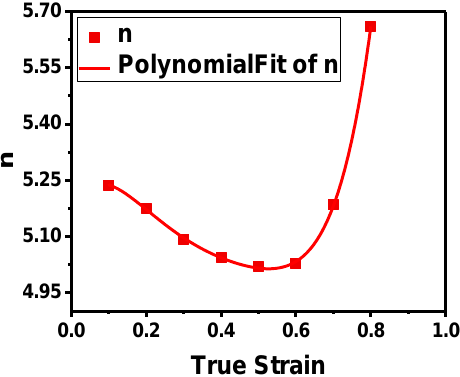
Figure 7. Relationship between true strain and n by polynomial fitting.